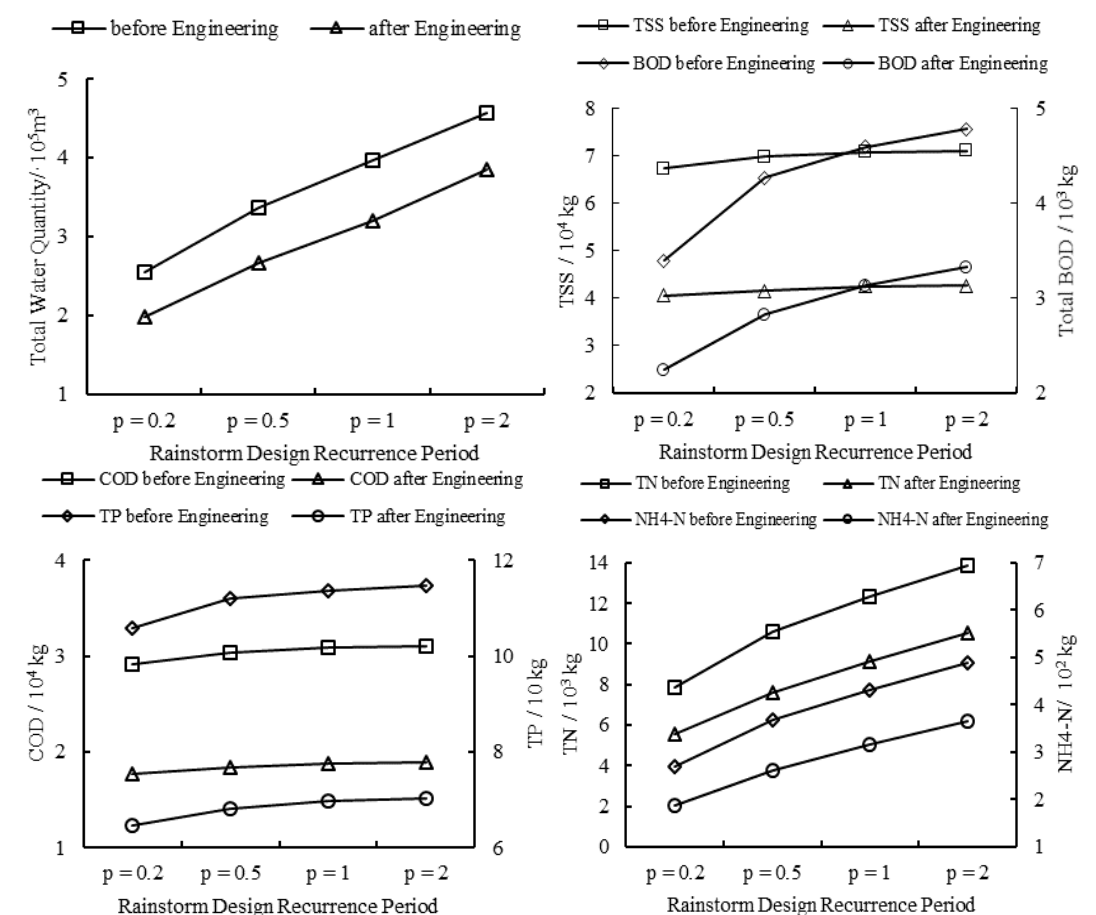
Figure 3. Comparisons of results for each index before and after construction of the deep tunnel for rainstorms with different design recurrence periods.